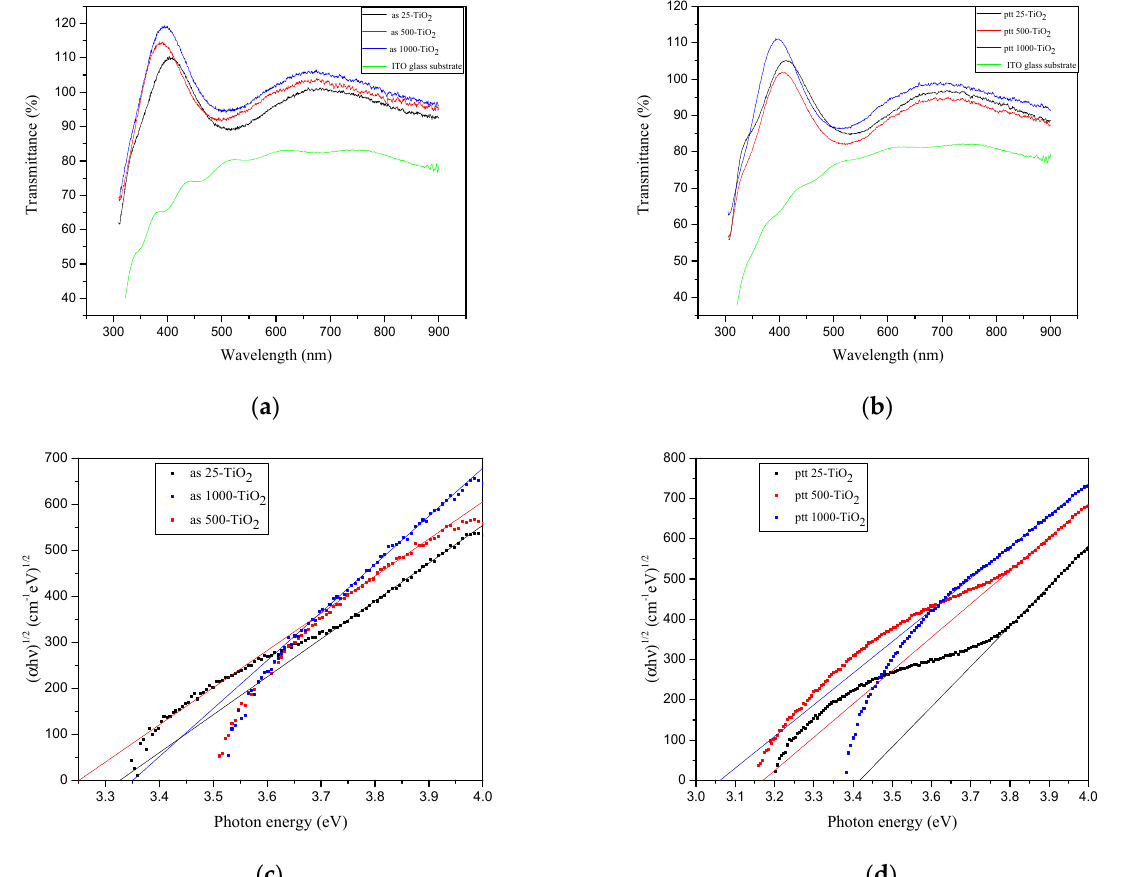
Figure 4. ( a , b ) UV − vis transmittance spectra of TiO 2 thin films and ITO glass substrate, ( c , d ) band gap energy determination (Tauc plot) of TiO 2 thin films deposited by PLD from targets sintered at different temperatures: ( a , c ) as-deposited and ( b , d ) after thermal treatment (150 °C for 30 min). Table 2. The estimated band gaps ( Eg ) of TiO 2 thin films deposited from unsintered and sintered targets, before and after thermal treatment.